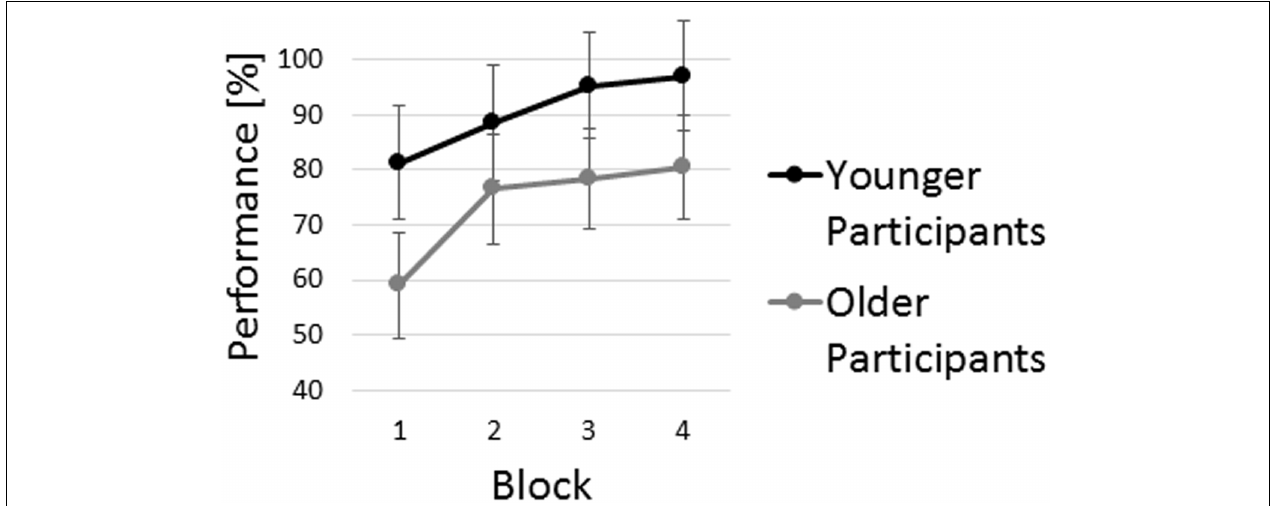
FIGURE 2 | Age group analysis of sequence learning performance in the visuospatial sequence learning task. Average performance of both age groups is displayed. Error bars indicate 95% confidence